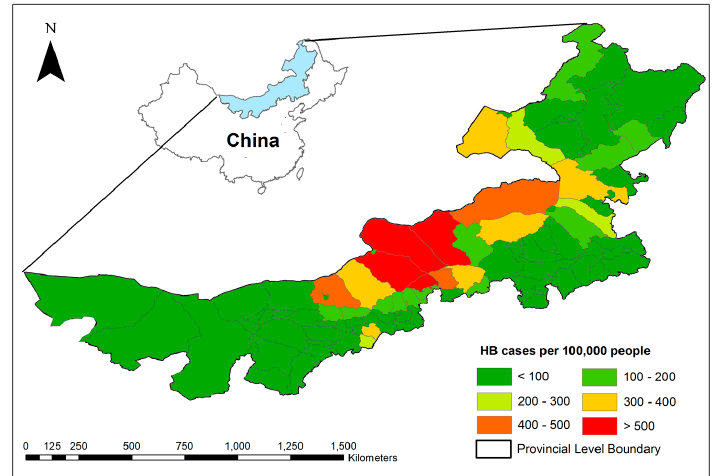
Figure 1. Eighty-nine counties of Inner Mongolia, China, with the numbers of human brucellosis (HB) cases per 100,000 people in 2010.